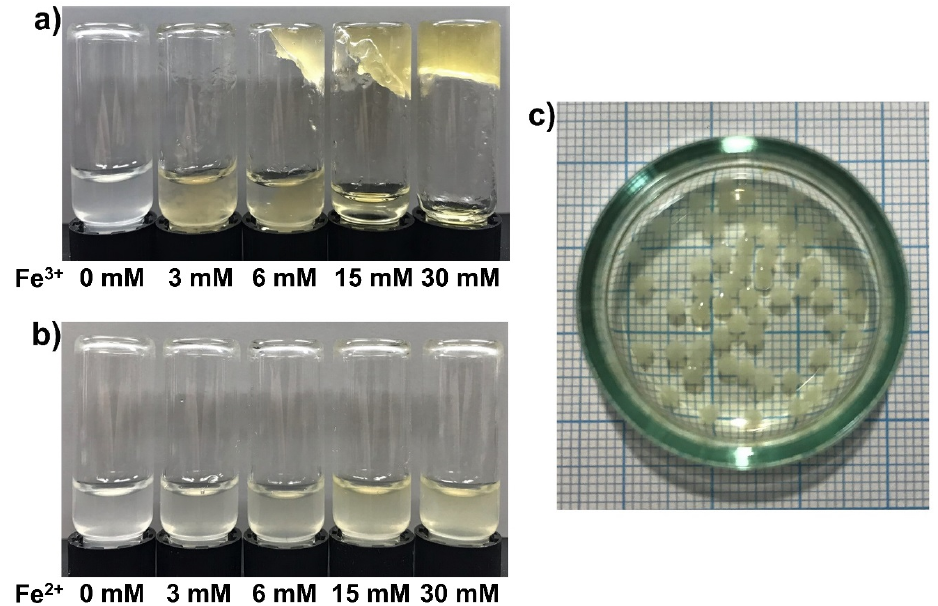
Figure 5. Results of the inverted vial tests. The Fe 3 + ( a ) and Fe 2 + ( b ) solution was mixed with the succinoglycan solution in vial, which was then turned upside down to check the gelation. The Fe ion concentrations were 0, 3, 6, 15, 30 mM (from left to right). Photograph of Fe 3 + -SG hydrogel beads ( c ).